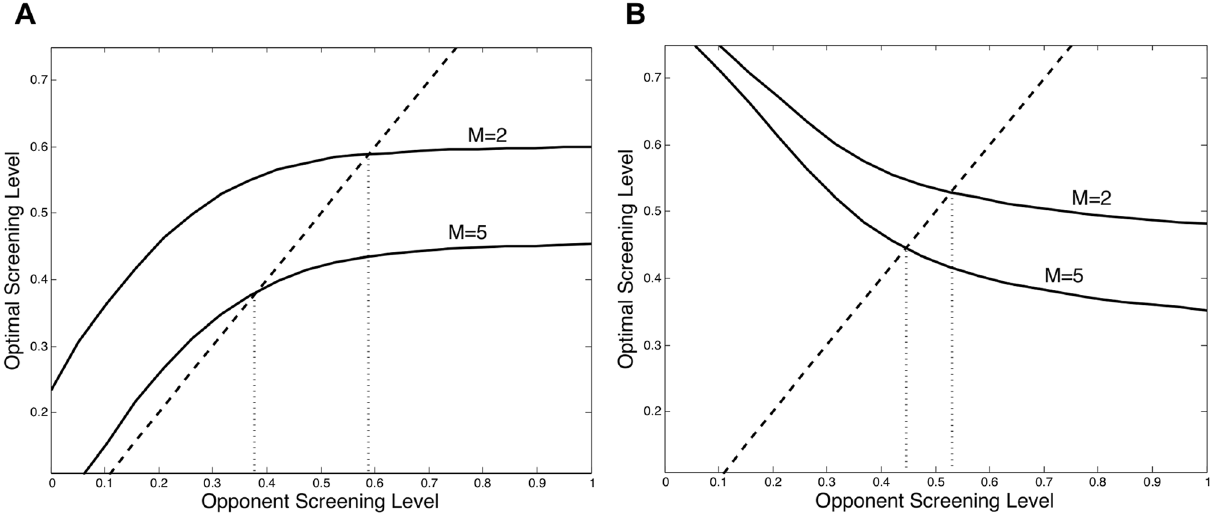
Figure 5. Crowding out with increased treatment efficacy. Treatment efficacy and the associated shape of the best response curve determine how much a change in the autonomy level will influence the equilibrium screening level. In Figure A, treatment is less effective ( t ~ : 01 ) and a decrease in screening autonomy increases the equilibrium screening level by much more than in Figure B where treatment is more effective ( t ~ : 3 ).